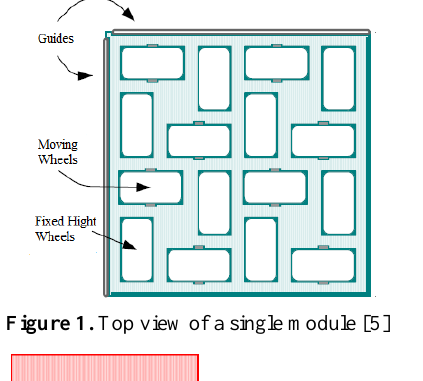
Figure 1. Top view of a single module [5]